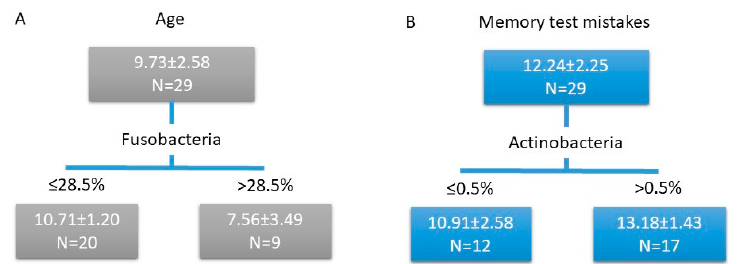
Figure 3. Regression tree model for age ( A ) and memory test mistakes ( B ). Scores in the rectangles (subgroups): mean ± SD.